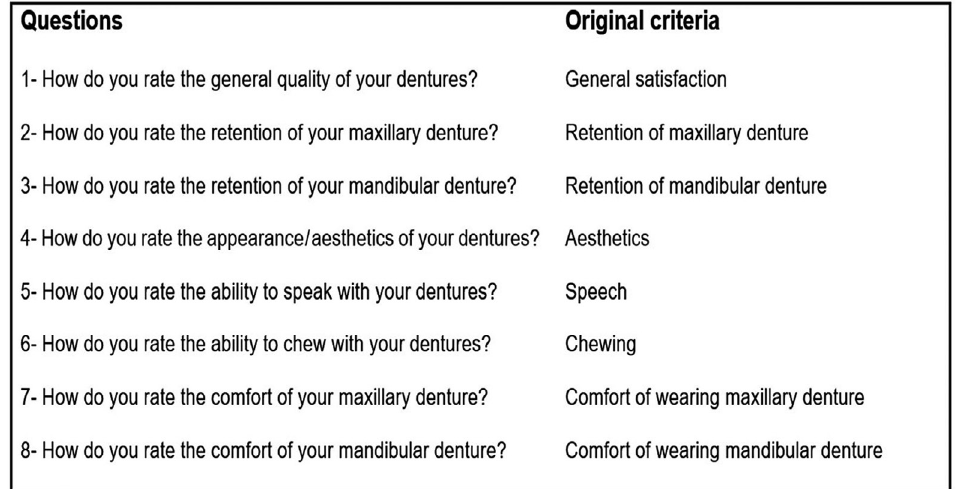
Figure 6- Questions of the satisfaction